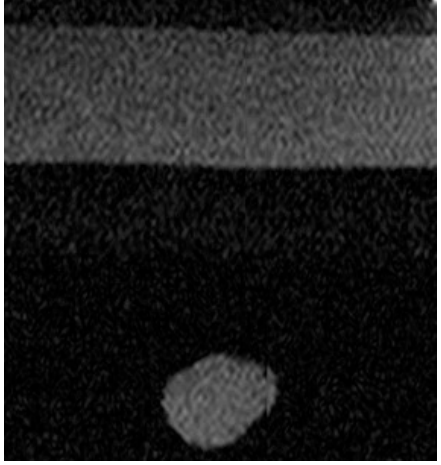
Figure 6. Cross section of an MRI image corresponding to that of an ultrasound image.